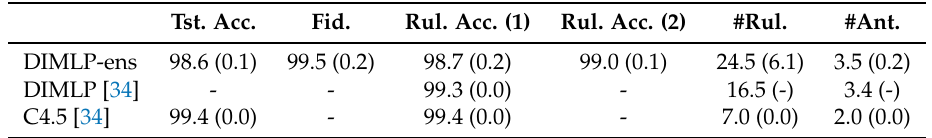
Table 2. Average results obtained by discretized interpretable multi-layer perceptron (DIMLP) ensembles, single DIMLP networks and C4.5 decision